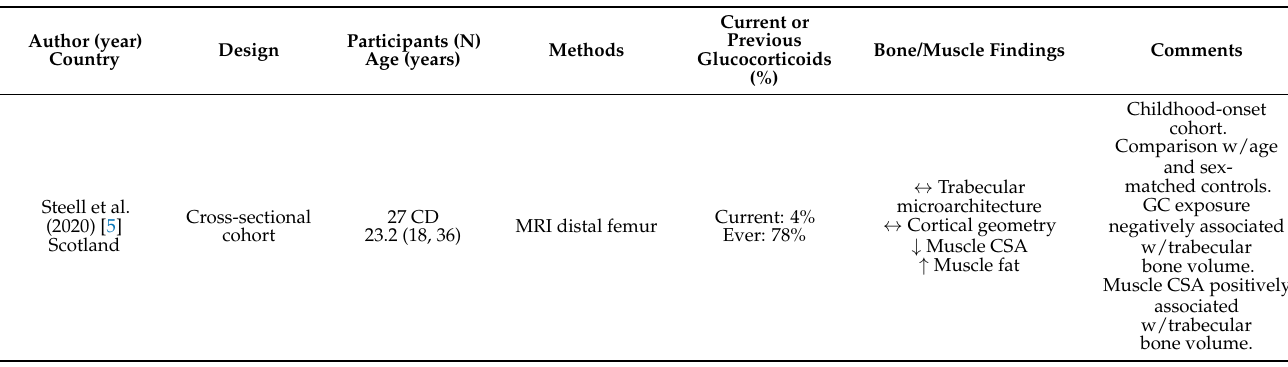
Table 2. Summary of major bone imaging studies in adults with